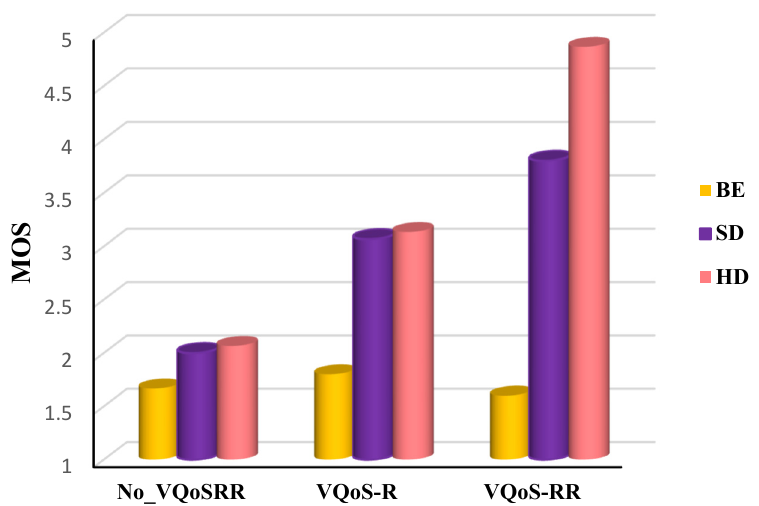
Figure 13. The average MOS value of the tested videos.